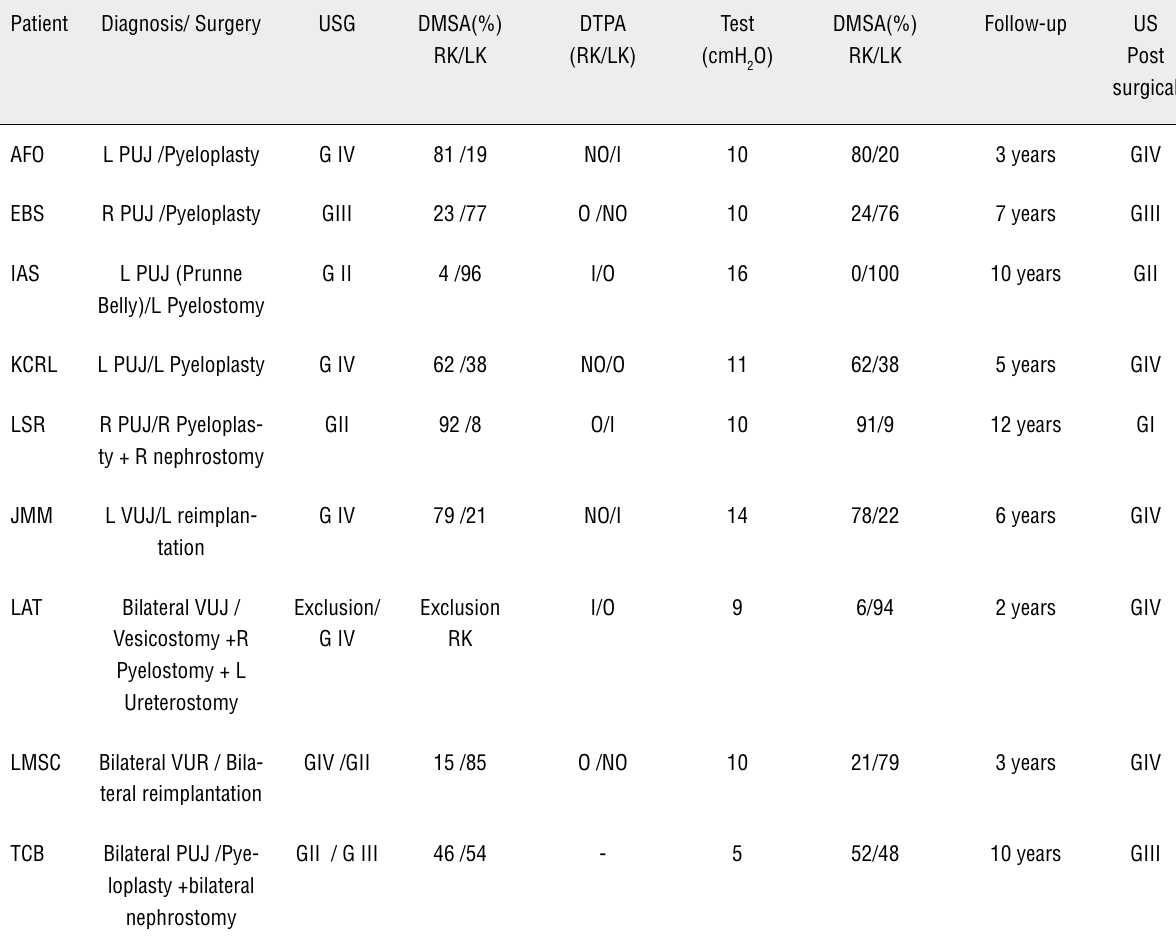
table 2 - Patients with test results considered non obstructive treated